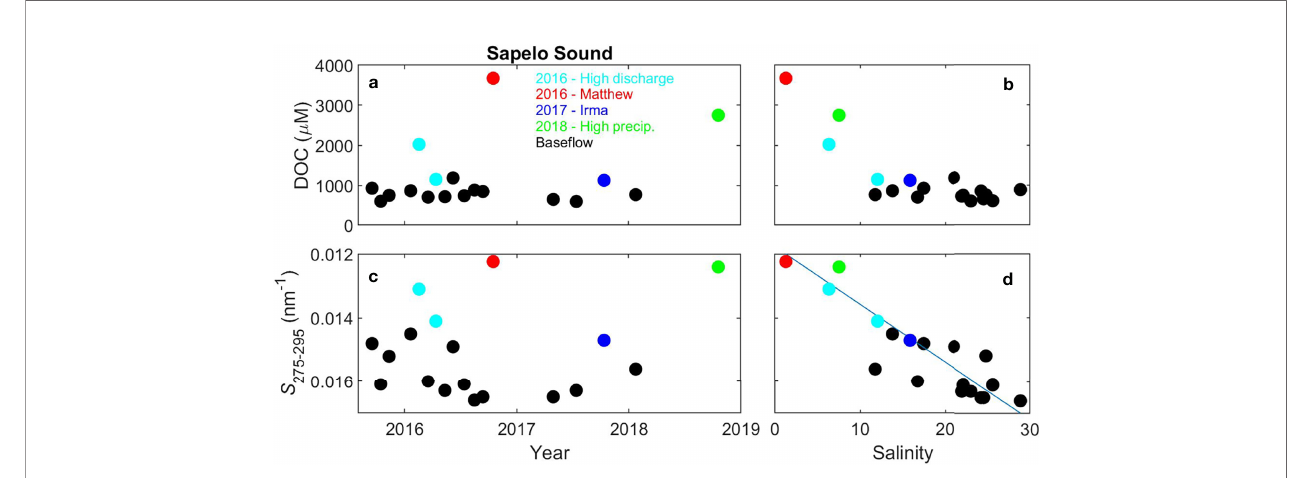
FIGURE 4 | Time series of (A) DOC concentration and (C) spectral slope coef fi cients ( S 275-295 ) at Sapelo Sound. (B) DOC concentration and (D) spectral slope coef fi cients are also plotted versus salinity. Blue line in (D) shows linear fi t to observations. Small spectral slope coef fi cients indicate a stronger terrigenous